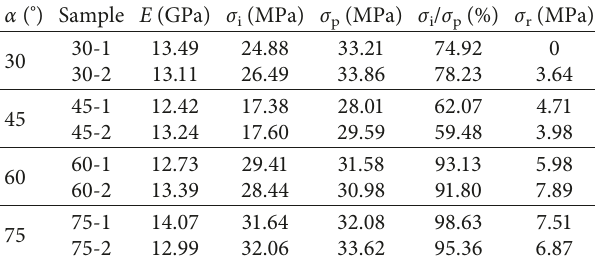
Table 2: Mechanical parameters of specimens containing a single flaw under uniaxial